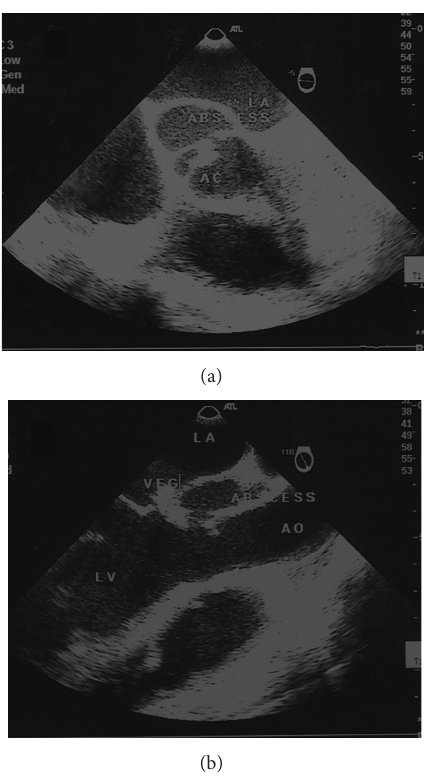
Figure 1: (a) Midesophageal-aortic valve short-axis view showing aorticrootabscess(arrowheads)inrelationtononcoronarycusp.(b) Midesophageal-LV long-axis view showing vegetation (VEG) on the base of anterior mitral leaflet with aortic root abscess (ABSCESS). LV: left ventricle; LA: left atrium; AO: aorta; VEG: vegetation; ABSCESS: aortic root abscess.